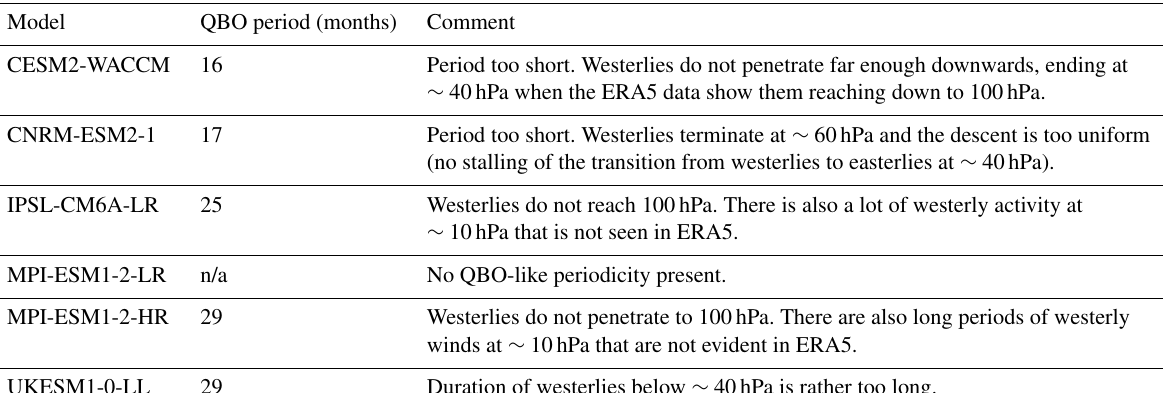
Figure 6. Multi-model mean difference in December to February (DJF) mean near-surface air temperature ( ◦ C) between ssp245 (2081– 2100) and the present day (PD; 2011–2030) (a) . Same as (a) but for the difference between ssp585 and PD (b) . Same as (a) but for the difference between G6sulfur and PD (c) . Multi-model mean difference in DJF land precipitation rate (mmd − 1 ) between ssp245 and PD (d) . Same as (d) but for the difference between ssp585 and PD (e) . Same as (d) but for the difference between G6sulfur and PD (f) . The PD data comprise years 2011–2014 from the CMIP6 historical simulations and years 2015–2030 from the corresponding ssp245 simulations. Areas where the difference is significant at the 5% level in a two-tailed t test are stippled. Table 2. The QBO period and a qualitative summary of the QBO simulation in ssp245 by each model’s r1 ensemble member (Fig. 7a–f) based on a comparison with ERA5 (Fig. 7g). The QBO period is estimated from the number of easterly-to-westerly zonal wind transitions at 30hPa during